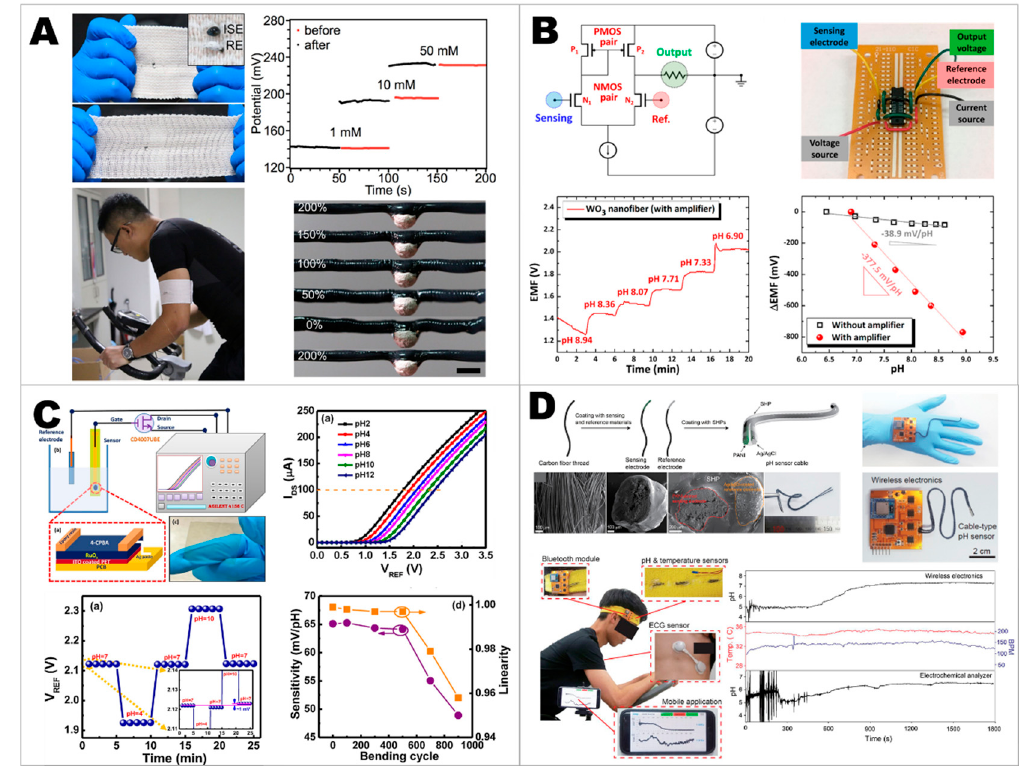
Figure 5. Examples of sensors for electrolyte detection. ( A ) Strain redistributed fibers for stretchable sodium sensors. Adapted with permission from [112], copyright 2020, Elsevier. ( B ) WO 3 nanofiber-polymer composites for the amplification system of pH sensors. Adapted with permission from [113], copyright 2019, American Chemical Society. ( C ) Sol-gel-derived ruthenium oxide on the flexible extended-gate field-effect transistor for super-Nernstian pH sensors. Adapted with permission from [114], copyright 2019, Elsevier. ( D ) Self-healable and flexible cable-type pH sensors. Adapted with permission from [115], copyright 2020, Elsevier.